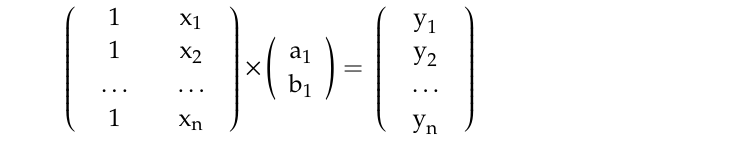
Figure 1. Batch file for MiePlot to automate stepping through particle sizes for intensity versus scattering angle simulations .